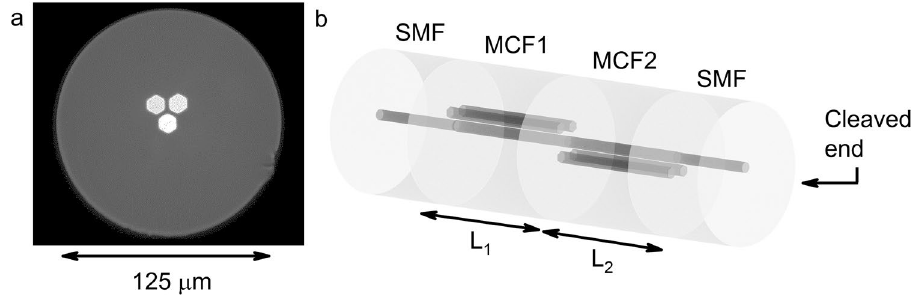
Figure 1. ( a ) Cross section of the asymmetric MCF. ( b ) Schematic layout of the device drawn with Blender v2.82 (https ://www.blend